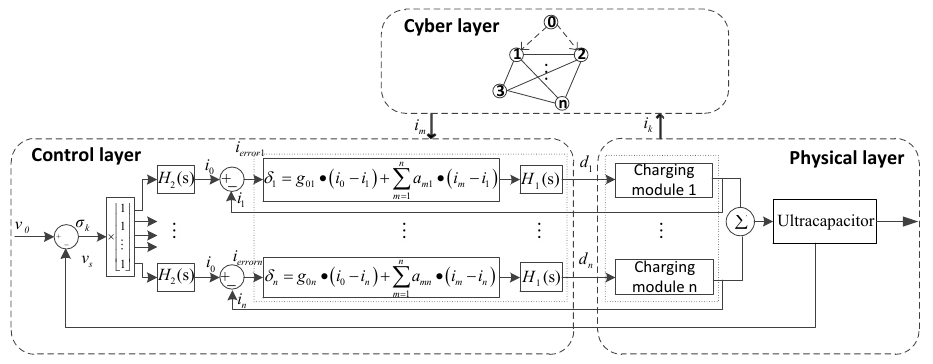
Figure 2. The cyber-physical representation of the proposed charging control